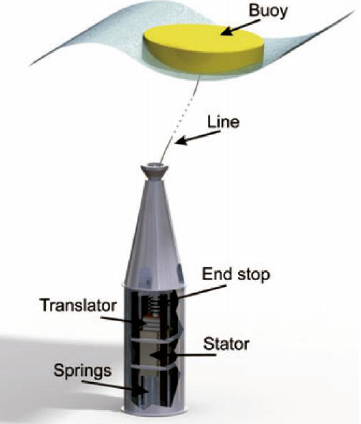
Figure 5. Direct drive cylindrical one-body point absorber WEC [27] .